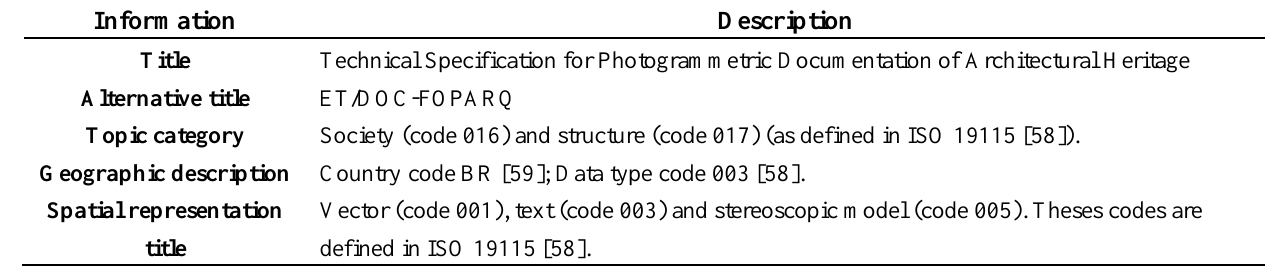
Table 2. Data Product Identification.